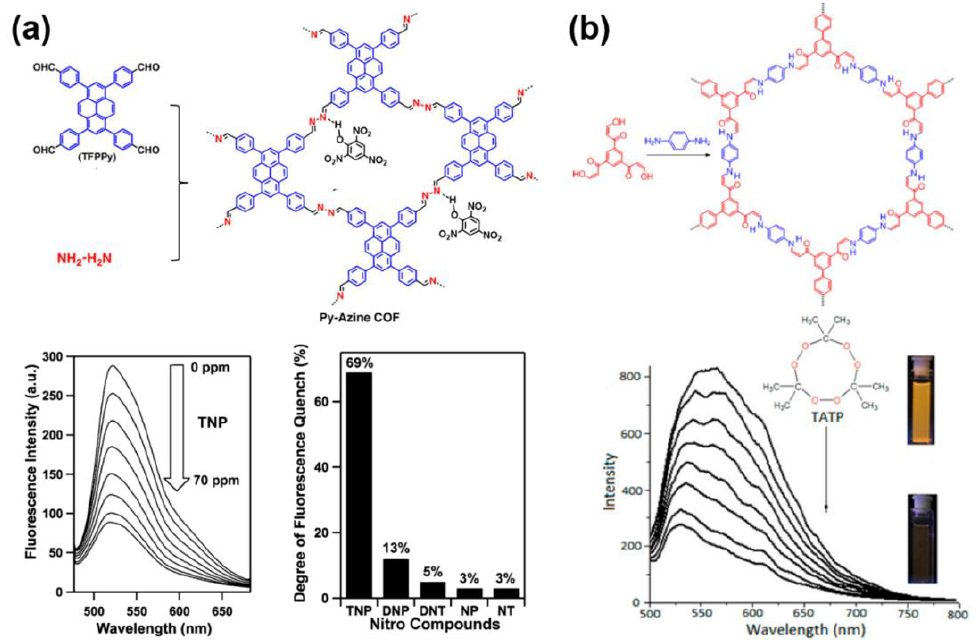
Figure 10. ( a ) The azine-linked COF for picric acid (2,4,6-trinitrophenol) detection. 2,4,6-trinitrophenol (TNP), 2,4-dinitrophenol (DNP), 2,4-dinitrotoluene (DNT), 2-nitrophenol (NP), and 2-nitrotoluene (NT) [116]. Copyright 2013 American Chemical Society; ( b ) The COF for TATP sensing [115]. Copy- right 2017 American Chemical